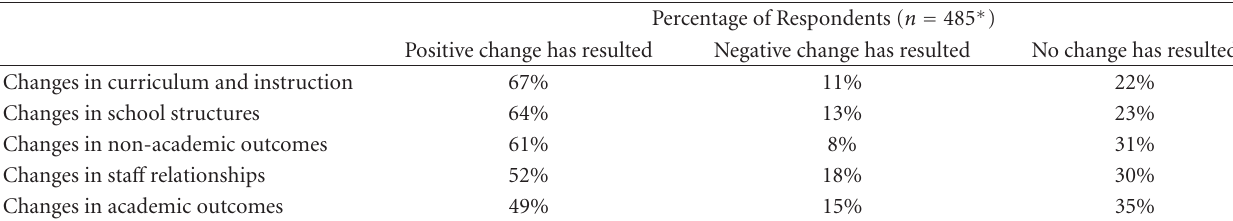
Table 2: Changes at the school that occurred as a result of